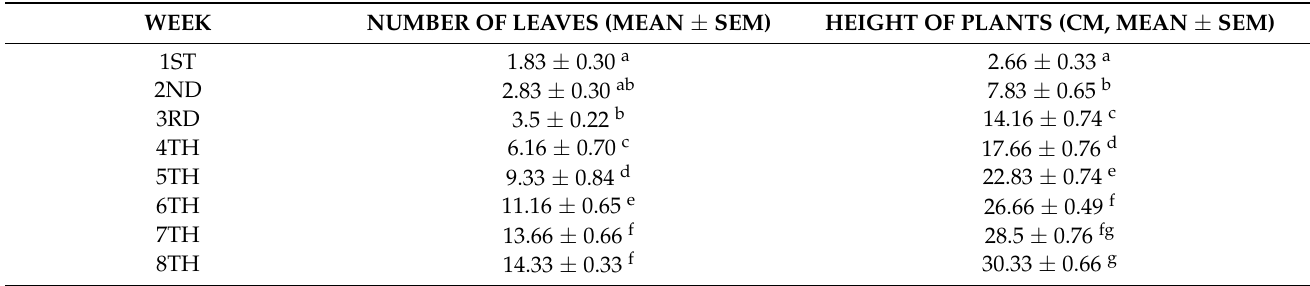
The data were recorded for up to 8 weeks. The data (10 replicates) represent the mean value ± SEM (standard error mean) and were found to be statistically operative and significant according to Duncan’s multiple range test (DMRT) at p ≤ 0.05. Mean ± SEM followed by the different letters within each column are significantly different according to DMRT (one-way ANOVA) at p ≤